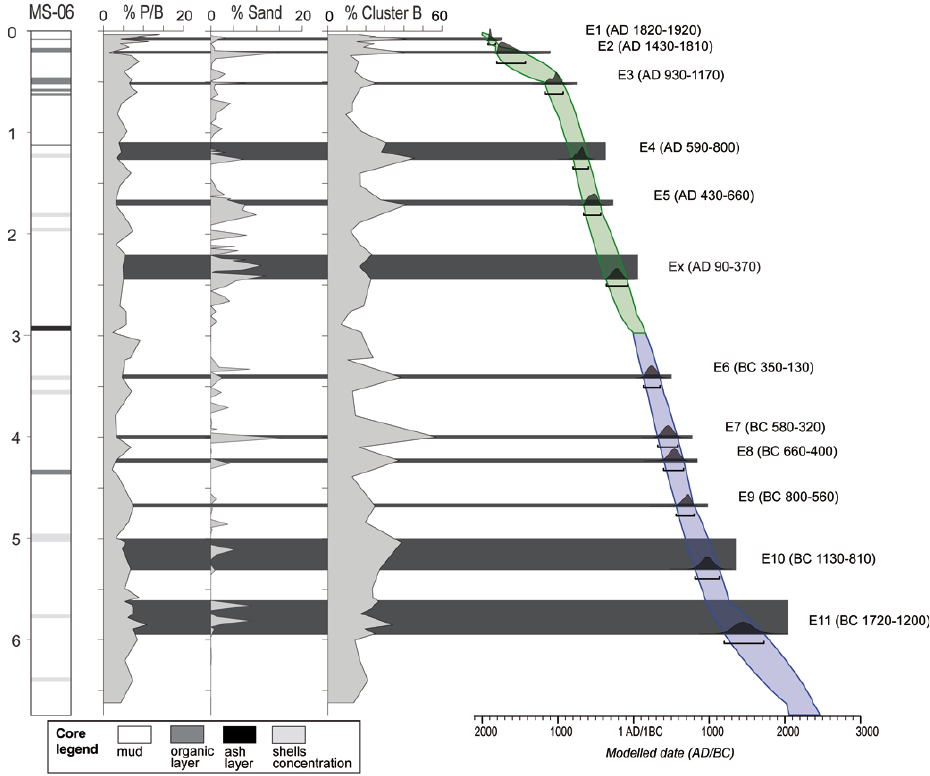
Fig. 4. Simplified log of the MS-06 core, plankton and benthos ratio ratio (P/B), sand distribution, and concentration of epiphytic displaced species. The gray horizontal bands highlight the 12 intervals of positive correlations between sedimentological and foraminiferal characteristics. On the right part of the figure, the age-depth model, built on the basis of a P sequence from OxCal 4.1software (Bronk Ramsey, 2008) with the probability distribution ranges (2 σ) , is shown. The change in colour of the age-depth model represents a strong boundary change inserted in coincidence of the Etna tephra (122BC). The 12 layers are dated following this age model, assuming the age of the deposit at the base of each of them as the closest to the beginning of the exceptional high-energy